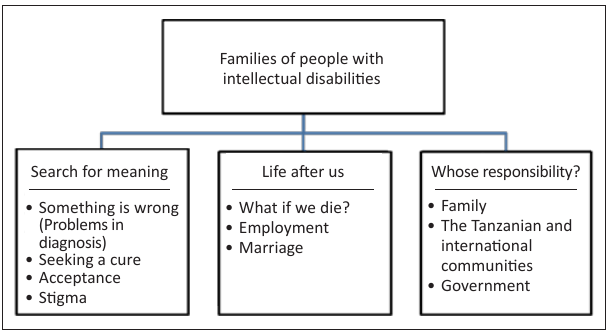
FIGURE 1: Results: Three themes of Dar es Salaam family experiences with intellectual